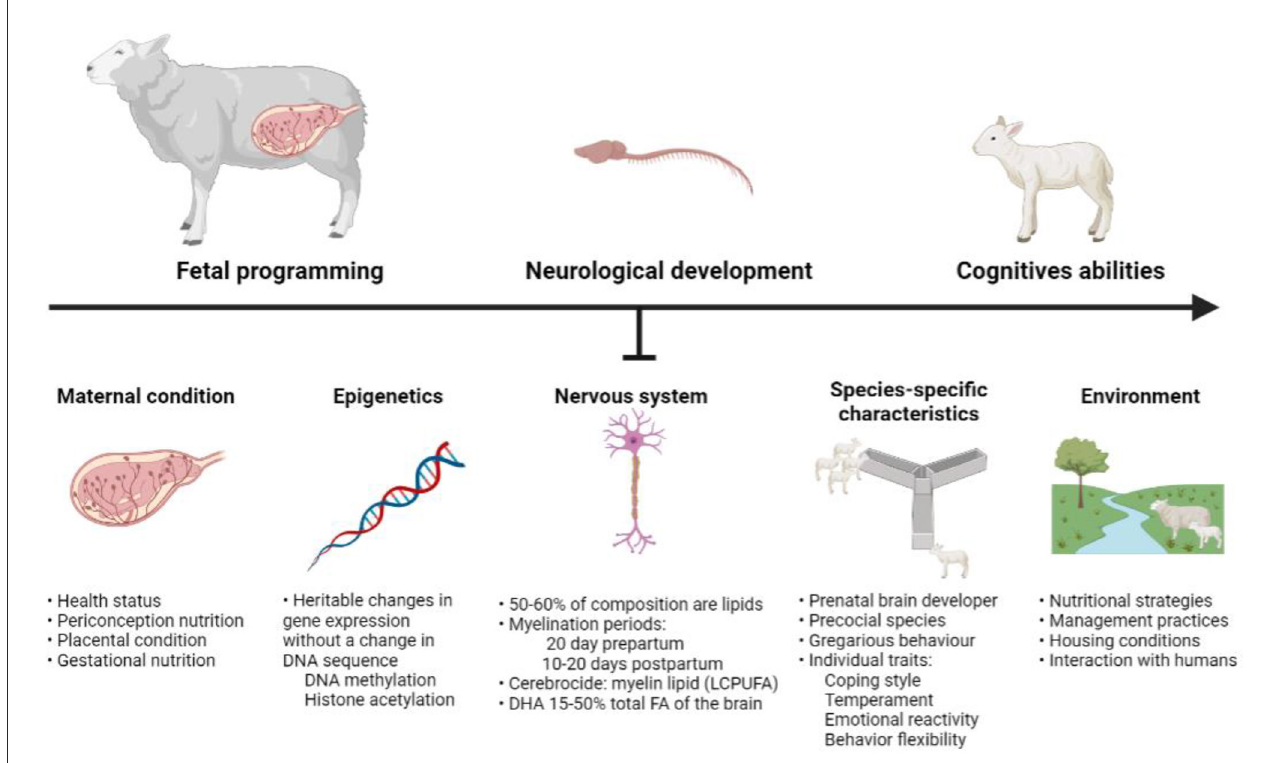
FIGURE4 Factors affecting the neurological development of the sheep. Created with